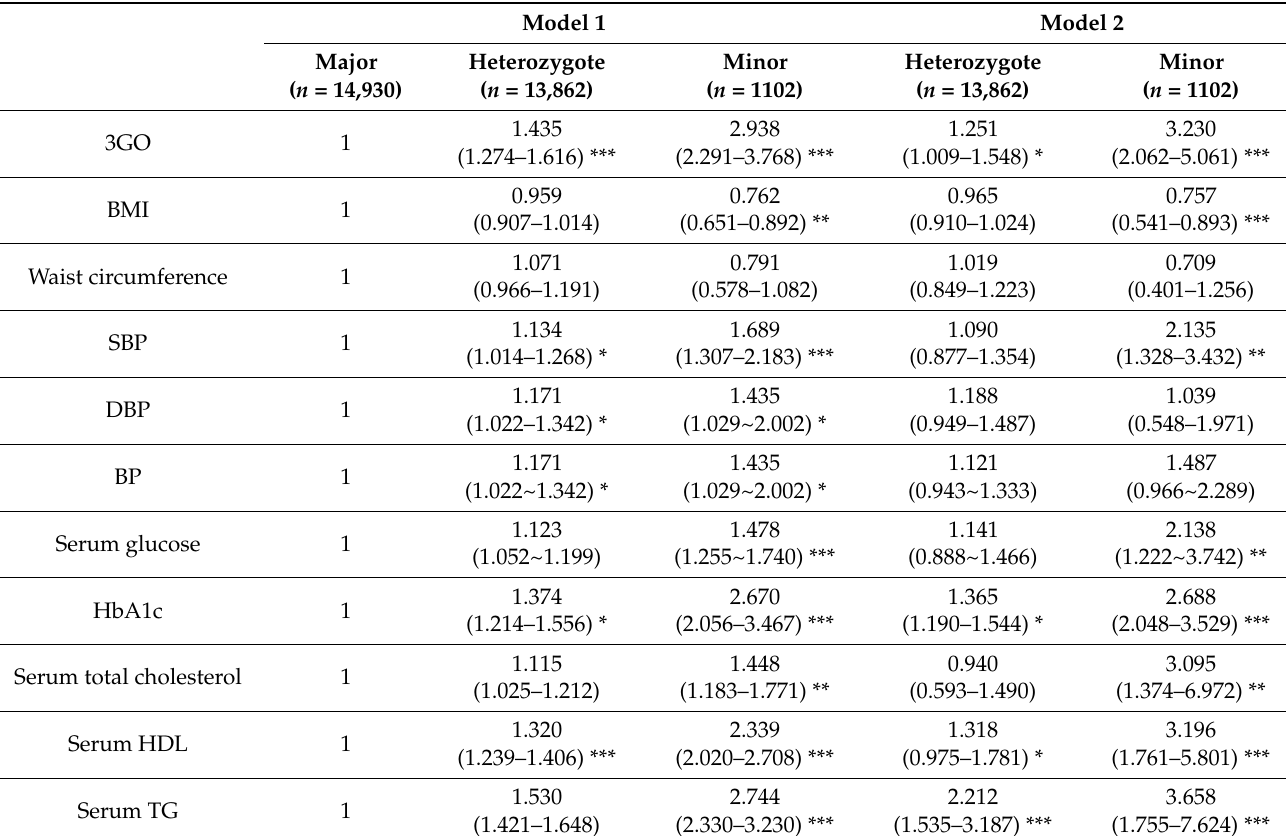
Table 4. Adjusted odds ratios for the risk of 3GO and related parameters according to the allele of the haplotype of 11q23 loci after covariate